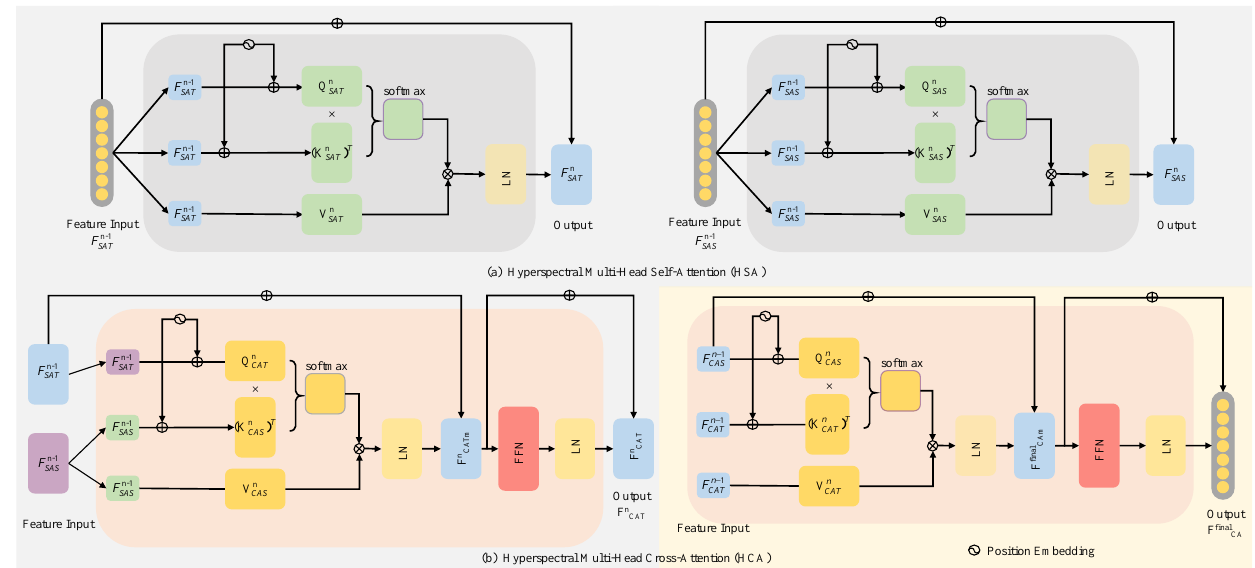
(a) Hyperspectral Multi-Head Self-Attention